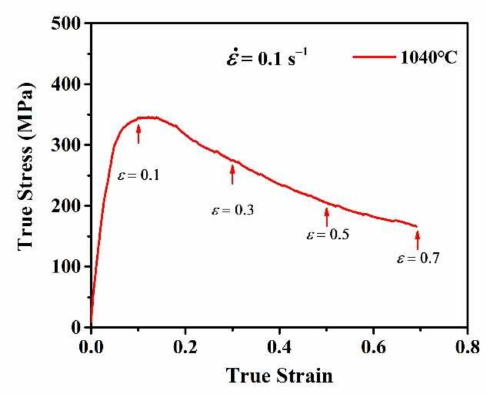
Figure 3. The true stress-strain curves of the hot-extruded GH4151 alloy in this